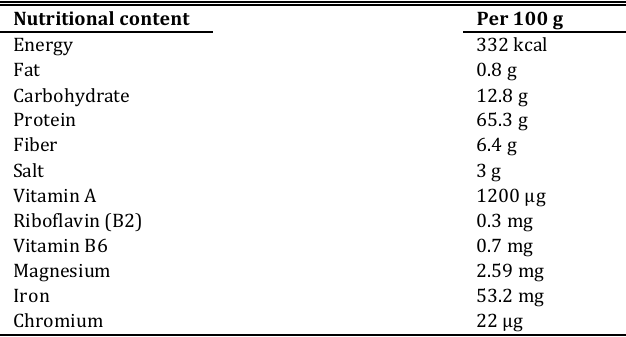
Table 1. The nutritional value of Spirulina algae used per 100